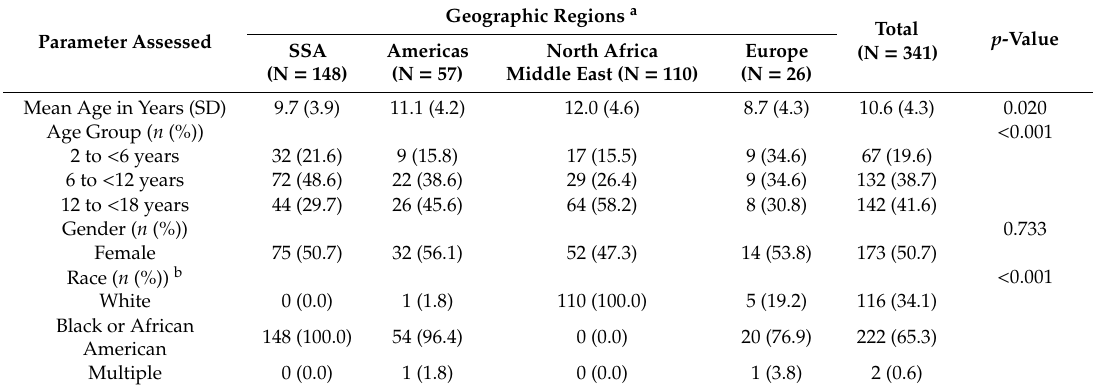
Table 1. Key demographics of subjects enrolled in the DOVE study in the di ff erent geographic regions.